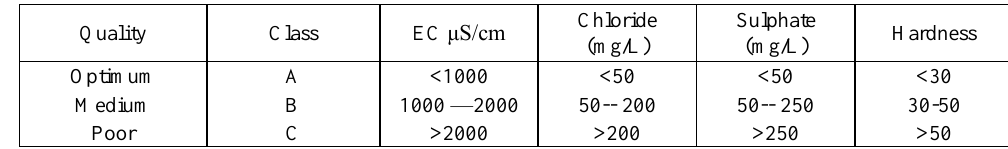
Table 5. Groundwater quality classification (Ducci,